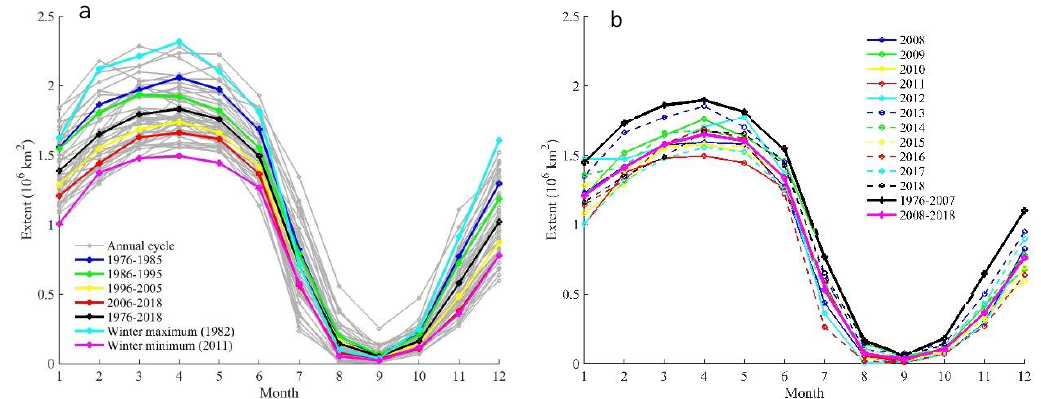
Figure 2. The interannual variation of the landfast ice extent during the entire time series 1976–2018 ( a ) and the new extended time series 2008–2018 ( b ) for the entire Arctic.